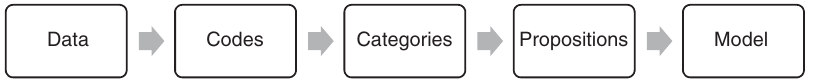
FIG. 2. Our approach is to capture the actions and beliefs present in interview and document data, describe what is going on through codes, organize those codes into descriptive categories, use propositions to interpret the categories, and finally combine the propositions to create a model.